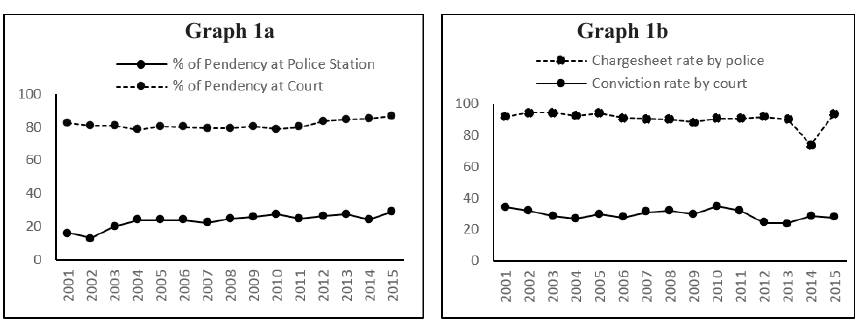
Graph 1: Disposal of crimes in terms of pendency percentage at police station and Court (Graph 1a), and charge sheet and conviction rate by police and court (Graph 1b),